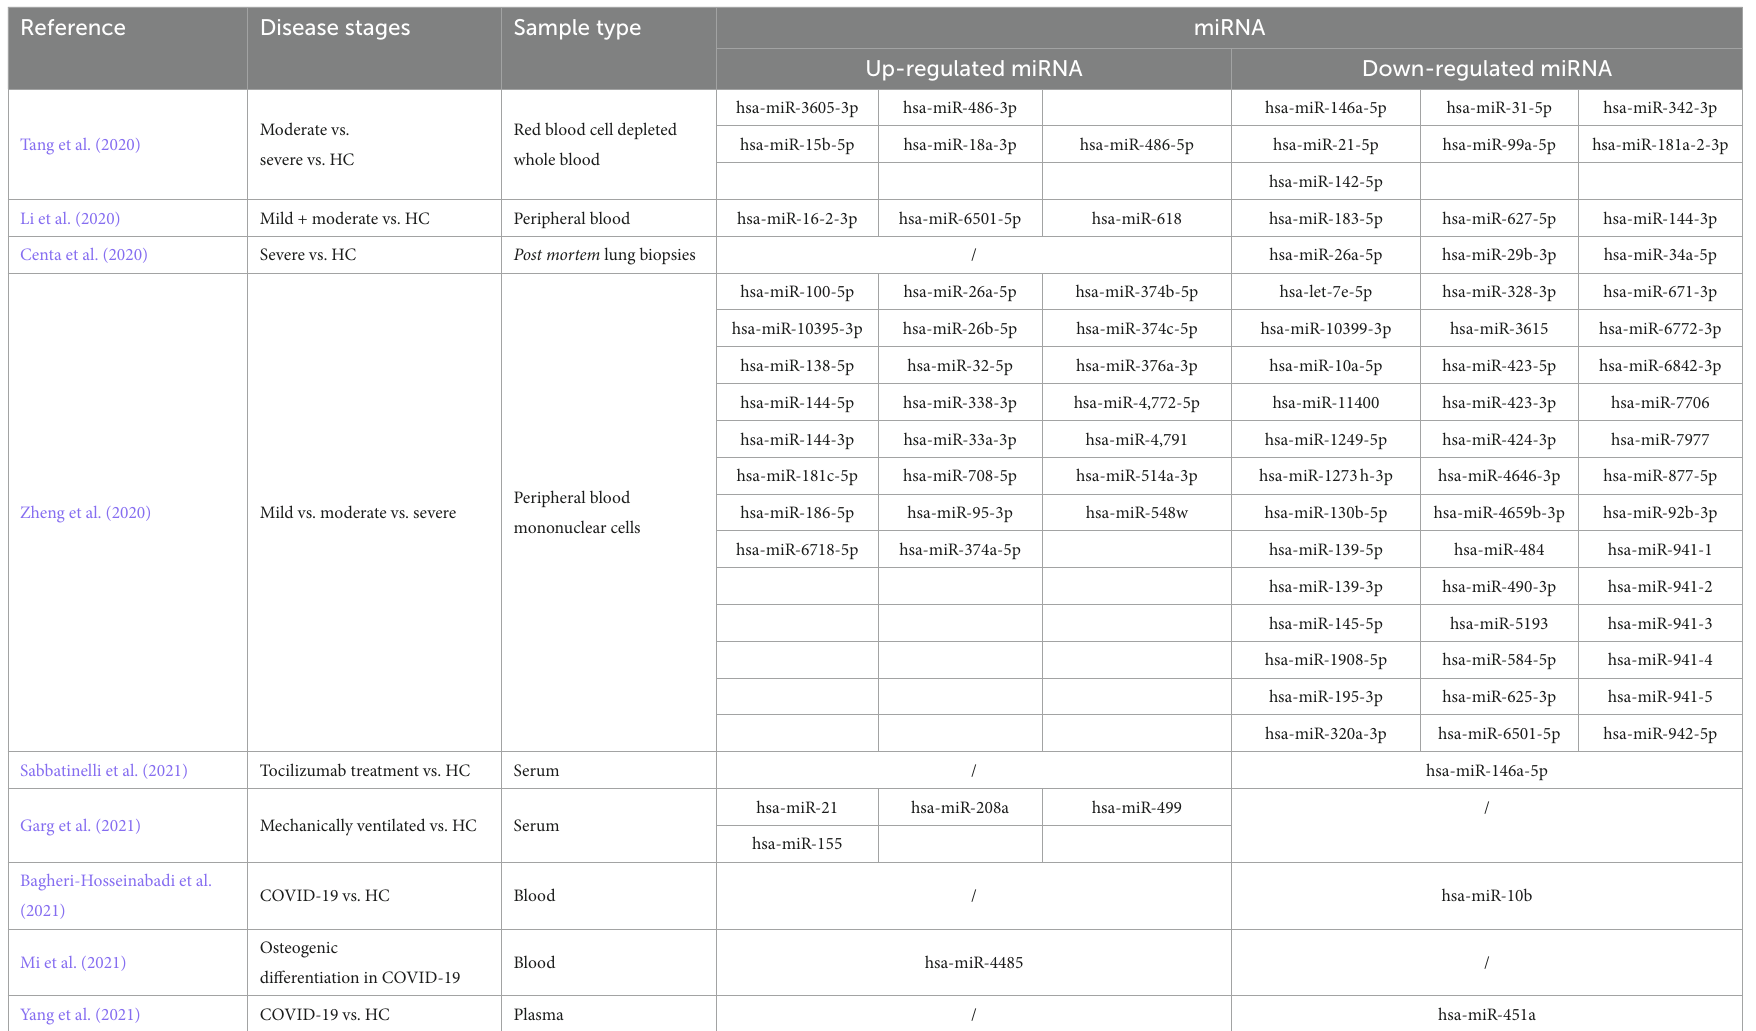
TABLE 1 miRNAs with changed expression levels in